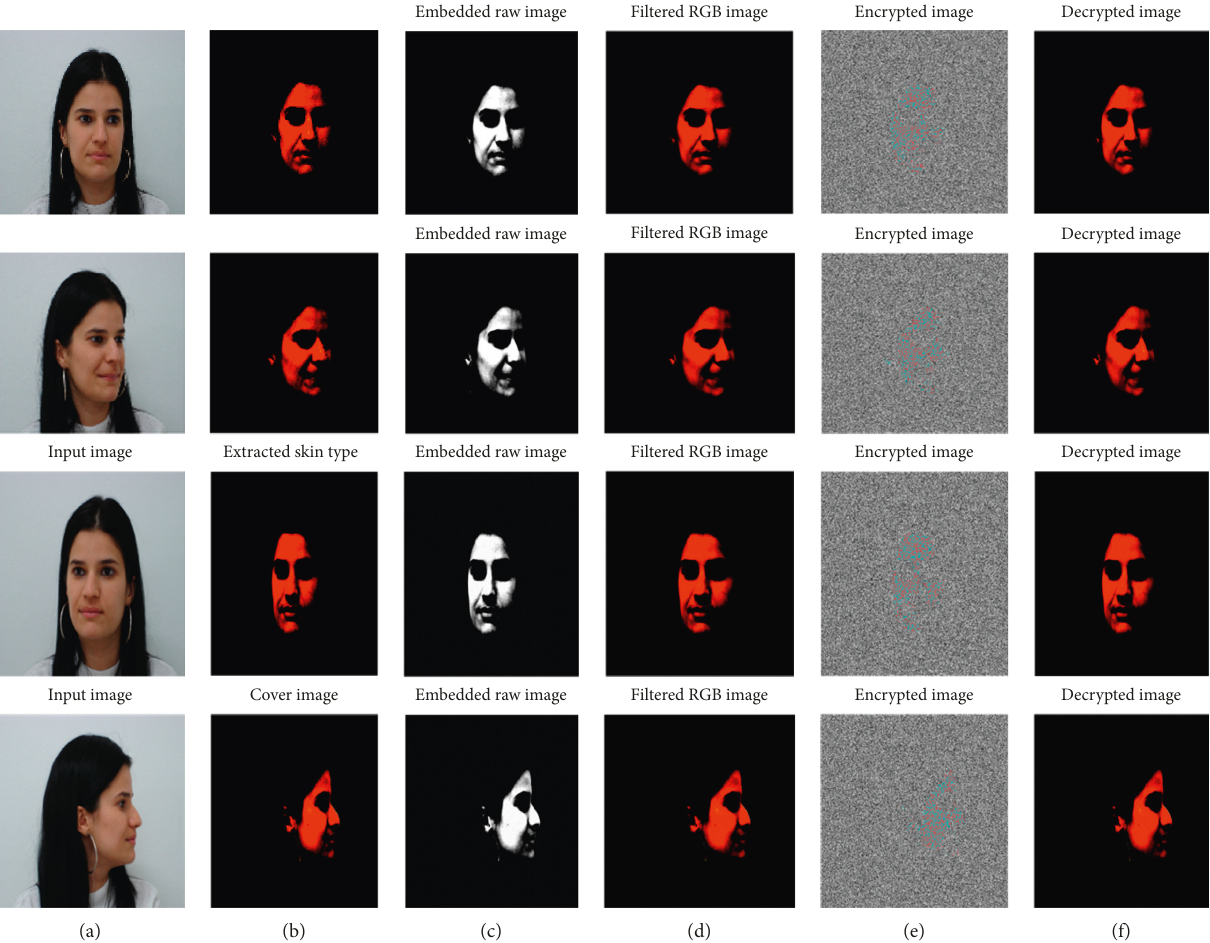
Figure 5: Simulation results of the embedding scheme using V-DWT and Lagrange interpolation encryption using different imaging conditions and different poses of an input image. (a) Original images (image 1 to image 4), (b) high-intensity layer as the cover image,